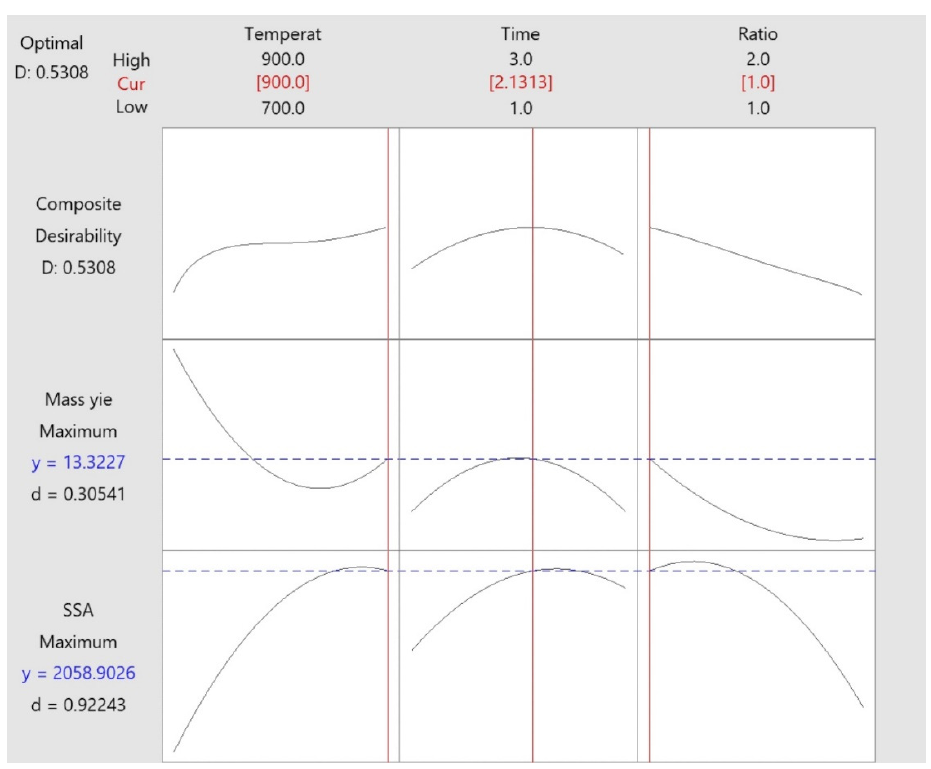
Figure 3. Optimization of the response mass yielding and SSA for production of BC.